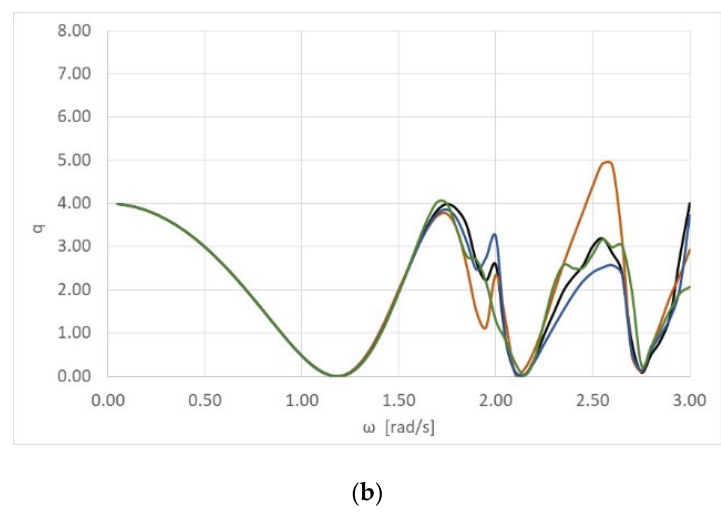
Figure 14. The q factor term of the WEC array, against ω , for the four different inter-body spacing cases: ( a ) the distance of the array from the breakwater equals L = D; ( b ) the distance of the array from the breakwater equals L = 5D.